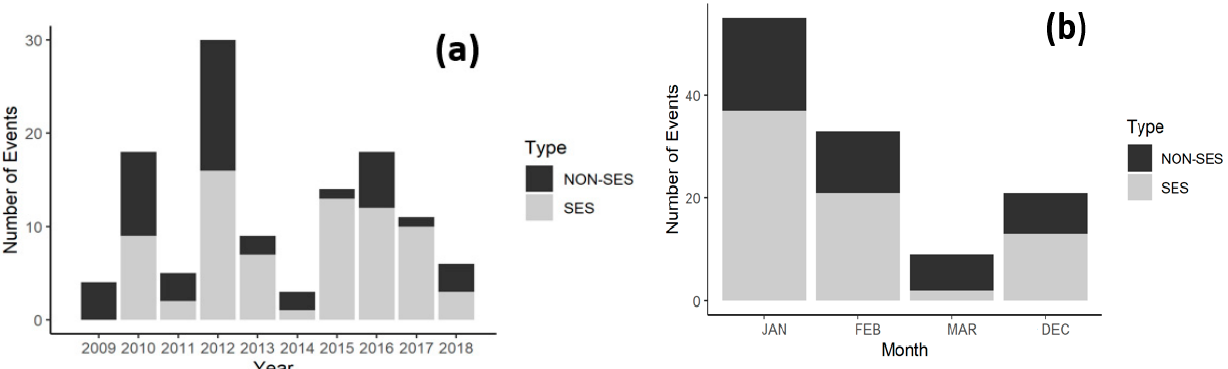
Figure 2. Annual distribution of sea-effect snow (SES) and non-SES events in the left panel ( a ), monthly distribution in the right panel ( b ).